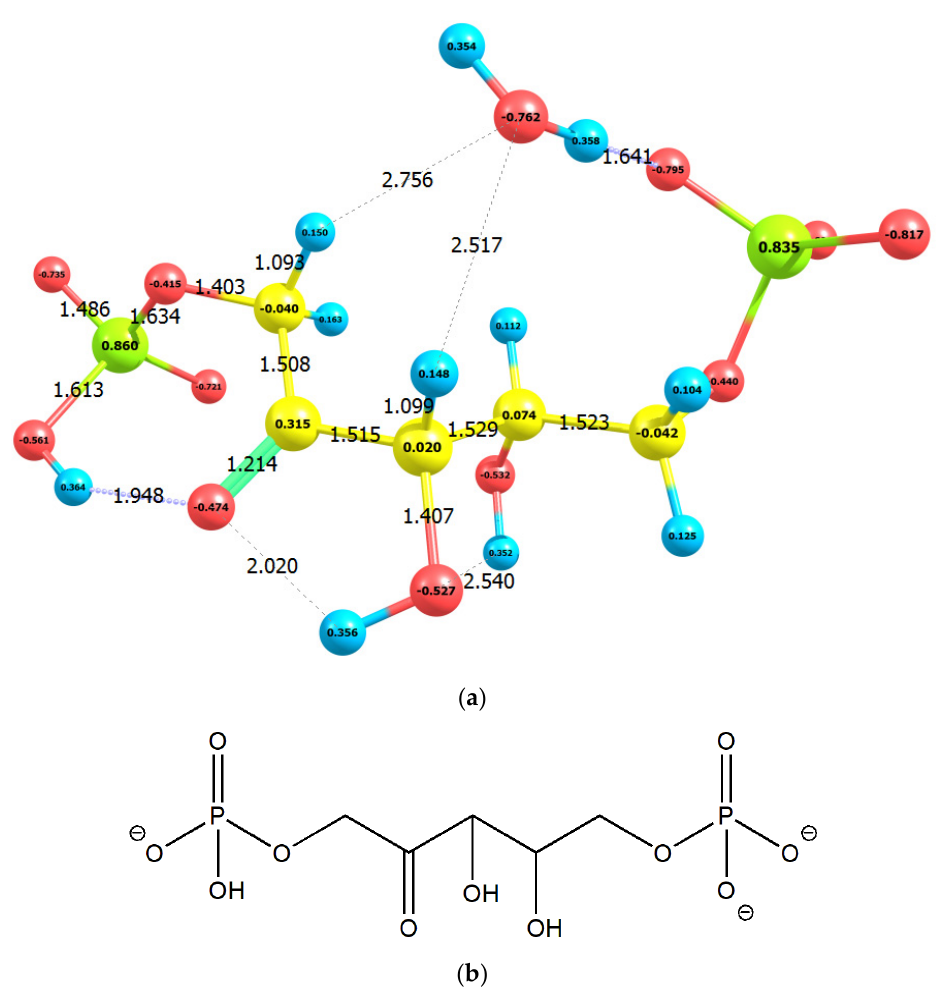
Figure A3. ( a ) The calculated geometric and electronic structure of protonated ribulose-1,5-bisphosphate with single water molecule (RuBP2 + ⋅ H 2 O); Q = − 3, M = 1, E 0 = − 48,531.77 eV, G 0 = − 48,527.58 eV. Hessian has no negative frequencies. ( b ) The scheme of 5-(hydrogen phospho- natooxy)-2,3-dihydroxy-4-oxopentyl phosphate.